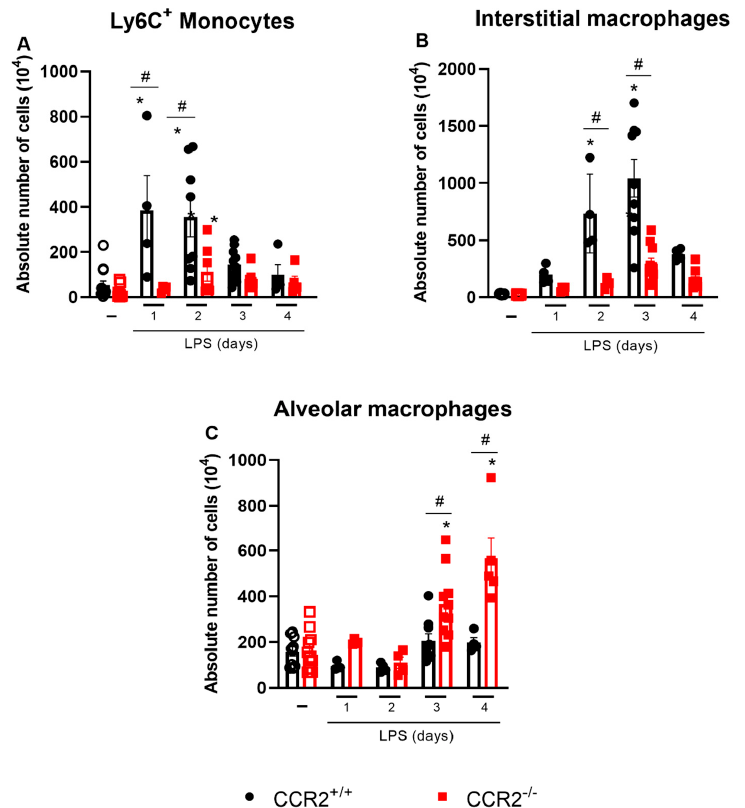
Figure 4. Largely reduced numbers of Ly6C + monocytes and interstitial macrophages but increased alveolar macrophage counts are observed in CCR2 − / − compared to CCR2 +/+ mice. CCR2 +/+ (black symbols) and CCR2 − / − (red symbols) C57BL/6 mice were challenged with LPS (12.5 µg/mouse) or PBS (ctrl group; -) and dissected at the indicated days. Absolute numbers of Ly6C + monocytes (CD45 + CD11b + SiglecF − Ly6G − Dump − CD103 − MHCII − Ly6C + cells) ( A ) interstitial macrophages (CD45 + CD11b + SiglecF − Ly6G − Dump − CD103 − MHCII + cells) ( B ) and alveolar macrophages (CD45 + SiglecF + CD11c + cells) ( C ) were quantified by flow cytometry. Compilation of three experiments. Data are shown as mean ± SEM. Each symbol represents data of an individual mouse. * p < 0.05 when compared with the healthy, unchallenged control group. # p < 0.05 when comparing wild type and knockout group at the same time point. ANOVA test followed by Bonferroni correction was used in panels B and C; Kruskal–Wallis with Dunn’s multiple comparisons test was used in panel A. n = 4–12.